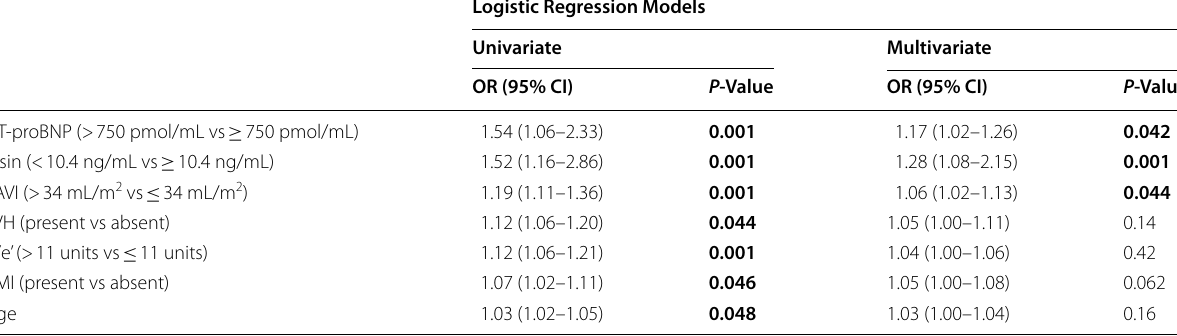
Table 3 Predictors for HF in T2DM patient populations